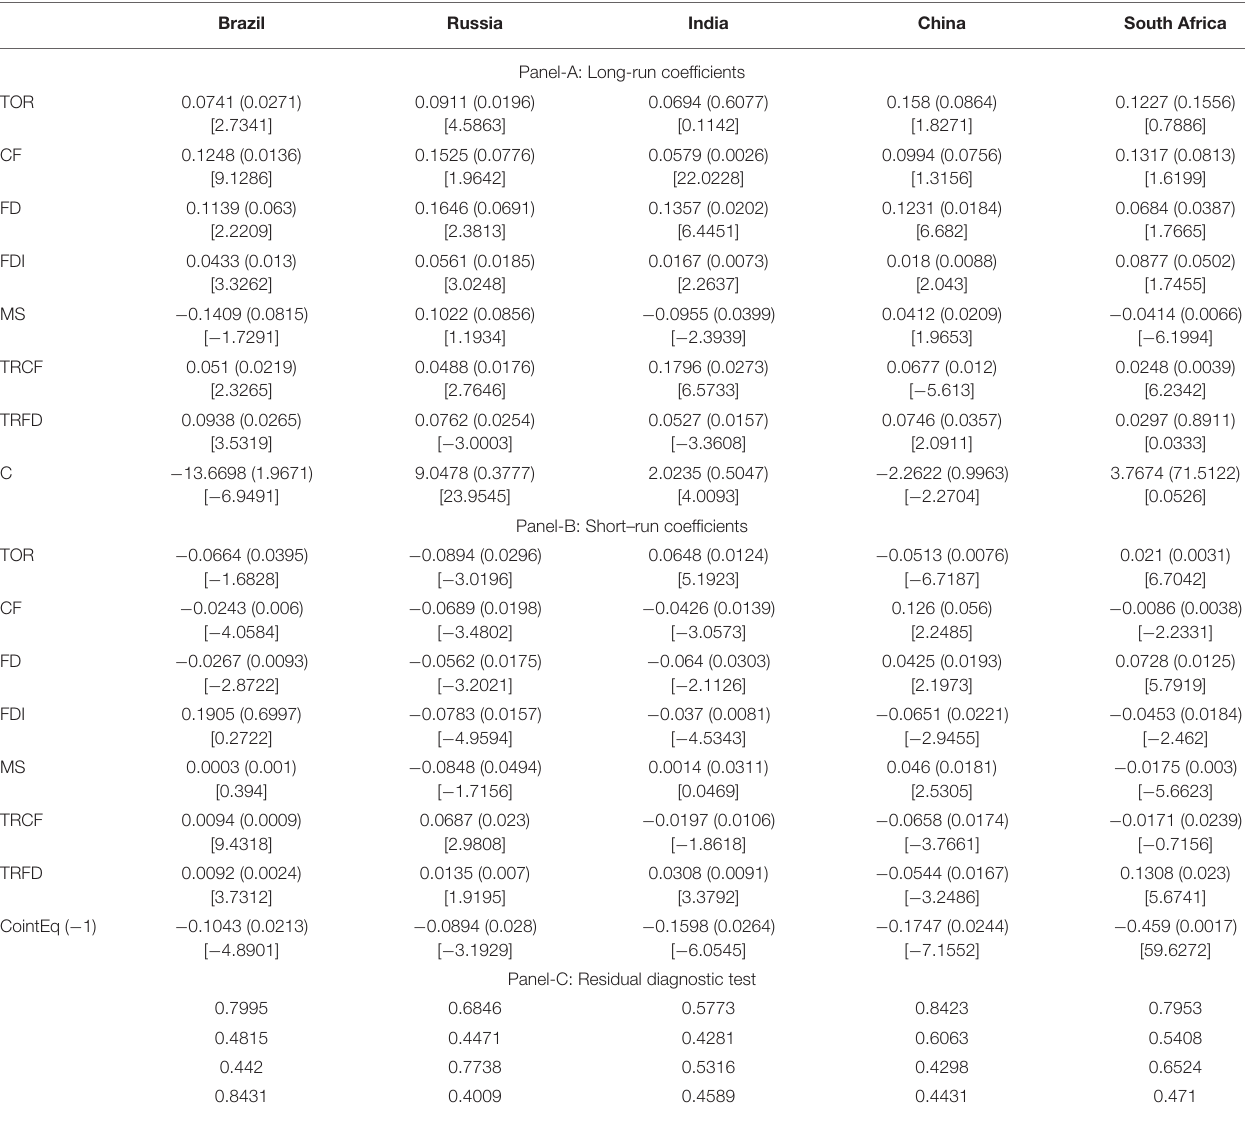
TABLE 9 | Model estimation with an interactive term for indirect